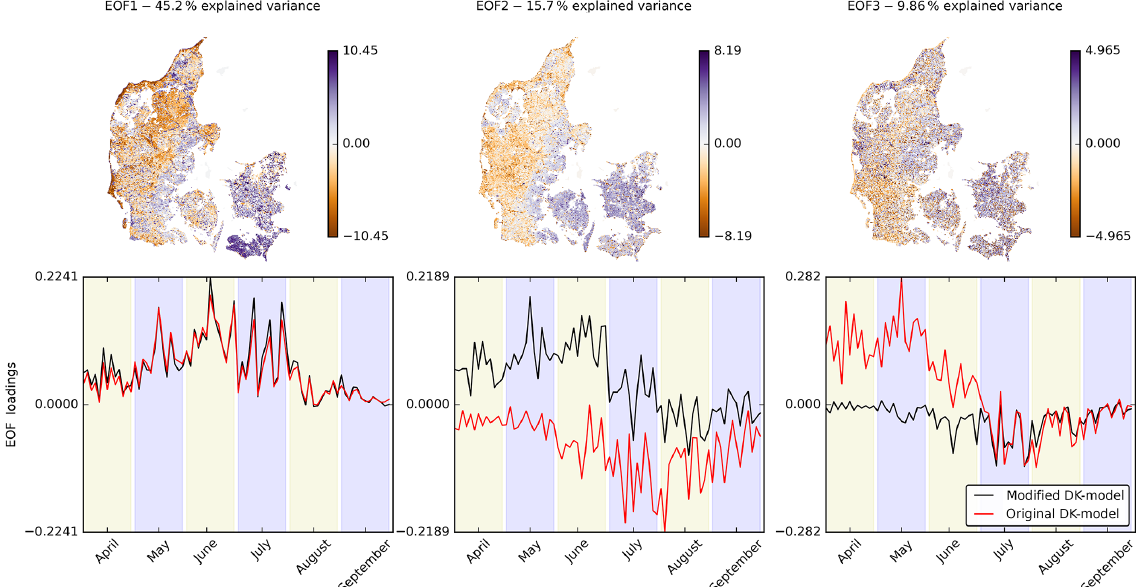
Figure 11. Maps of the first three EOFs comparing the original setup of the DK-model and the modified version of